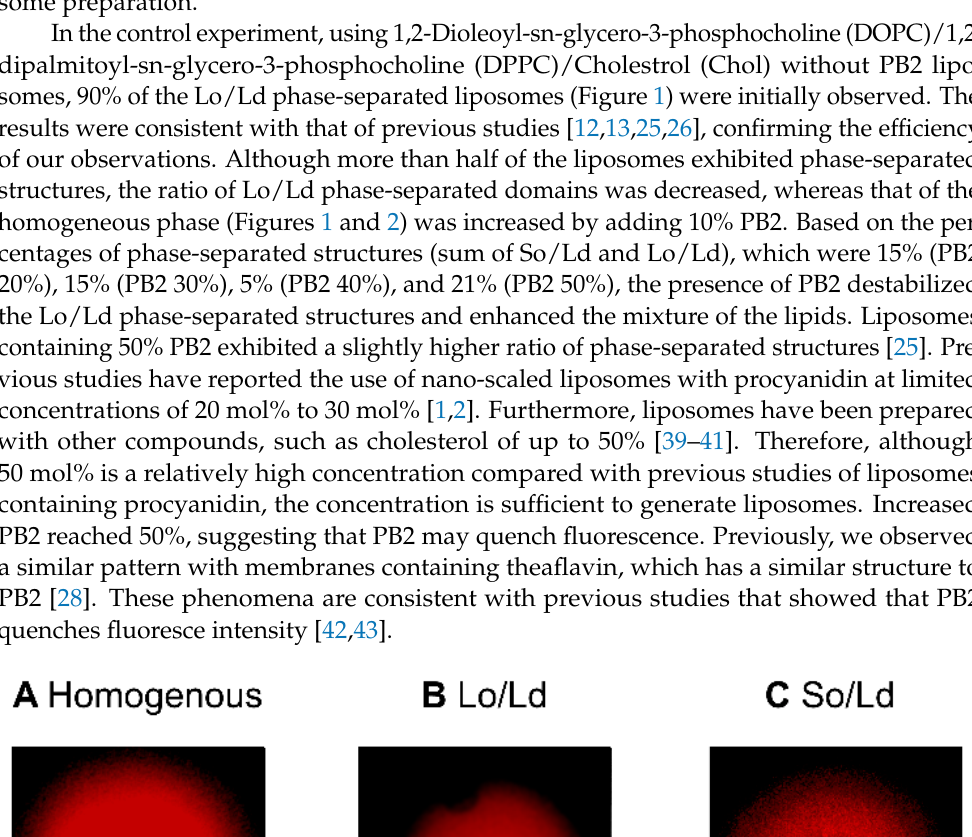
Figure 2. The percentage of phase-separated structures. 1,2-Dioleoyl-sn-glycero-3-phosphocholine (DOPC)/1,2-dipalmitoyl-sn-glycero-3-phosphocholine (DPPC)/cholesterol (Chol) with various concentrations of pro-cyanidin b2 (PB2) are shown. White, bright gray, and dark gray bars denote homogenous, liquid-ordered (Lo)/liquid-disordered (Ld), and solid-ordered (So)/Ld phases, respectively. Lipid compositions of the liposomes for each observation were DOPC/DPPC/Chol/PB2 40:40:20:0, 36:36:18:10, 32:32:16:20, 28:28:14:30, 24:24:12:40, and 20:20:10:50. According to previous studies, DOPC/DPPC 40:40:20 was used as a control for Lo/Ld phase-separation [12,13,25,26]. In the control experiment for DOPC/DPPC without PB2 liposomes, 45% of So/Ld phase-separated liposomes (Figure 2C) were observed. This ratio was slightly lower compared with the phase-separated liposomes in previous studies [25], although phase- separated liposomes were definitely observed. The percentage of So/Ld fluctuated with increasing PB2 concentrations (Figure 3). PB2 exerts certain So/Ld phase-separation effects on membranes, although these effects are not dependent upon PB2 concentration. Although this is an interesting phenomenon, the underlying mechanisms remain unclear. A liquid-ordered phase was observed at 40% and 50% PB2. This was considered significant, as PB2 negatively affects the stability of the liquid-ordered phase, whereas it did not significantly affect the solid-ordered phase. Another important finding was that a relatively higher PB2 concentration induced a liquid-ordered phase on the membrane in the absence of Chol (Figure 3).